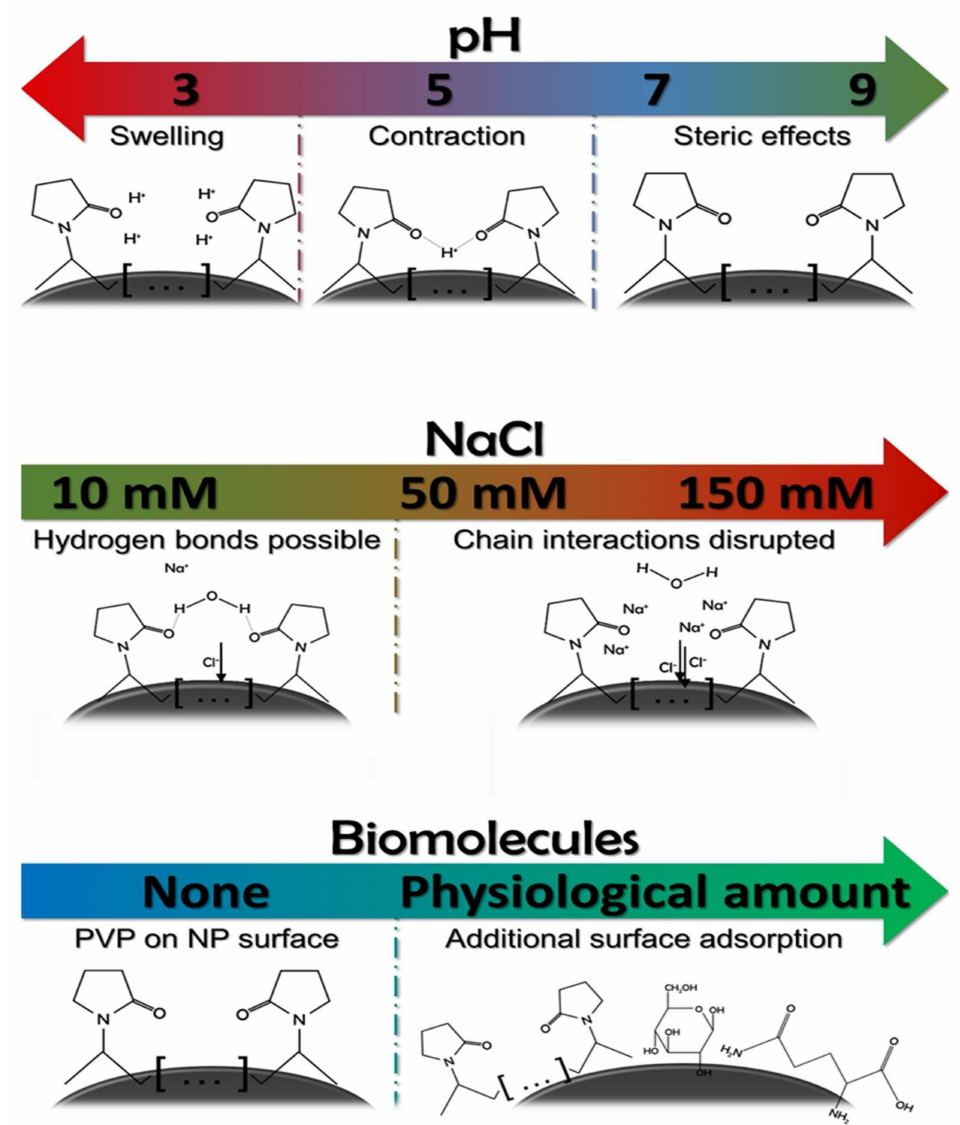
Scheme 1. The effect of environmental conditions on the steric stabilization of silver nanoparticles protected by polyvinyl